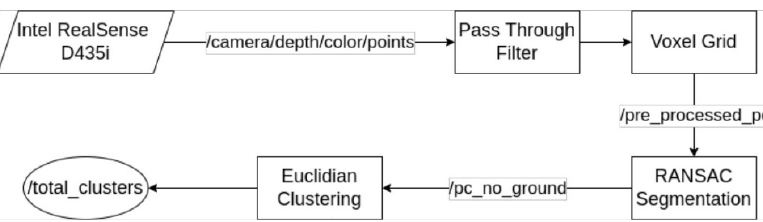
Figure 2. Processing flowchart.